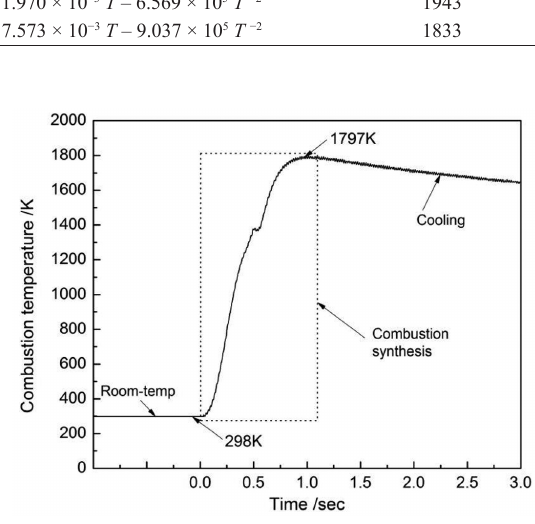
Figure 3. The typical combustion temperature−time curve of MoSi specimen. 2